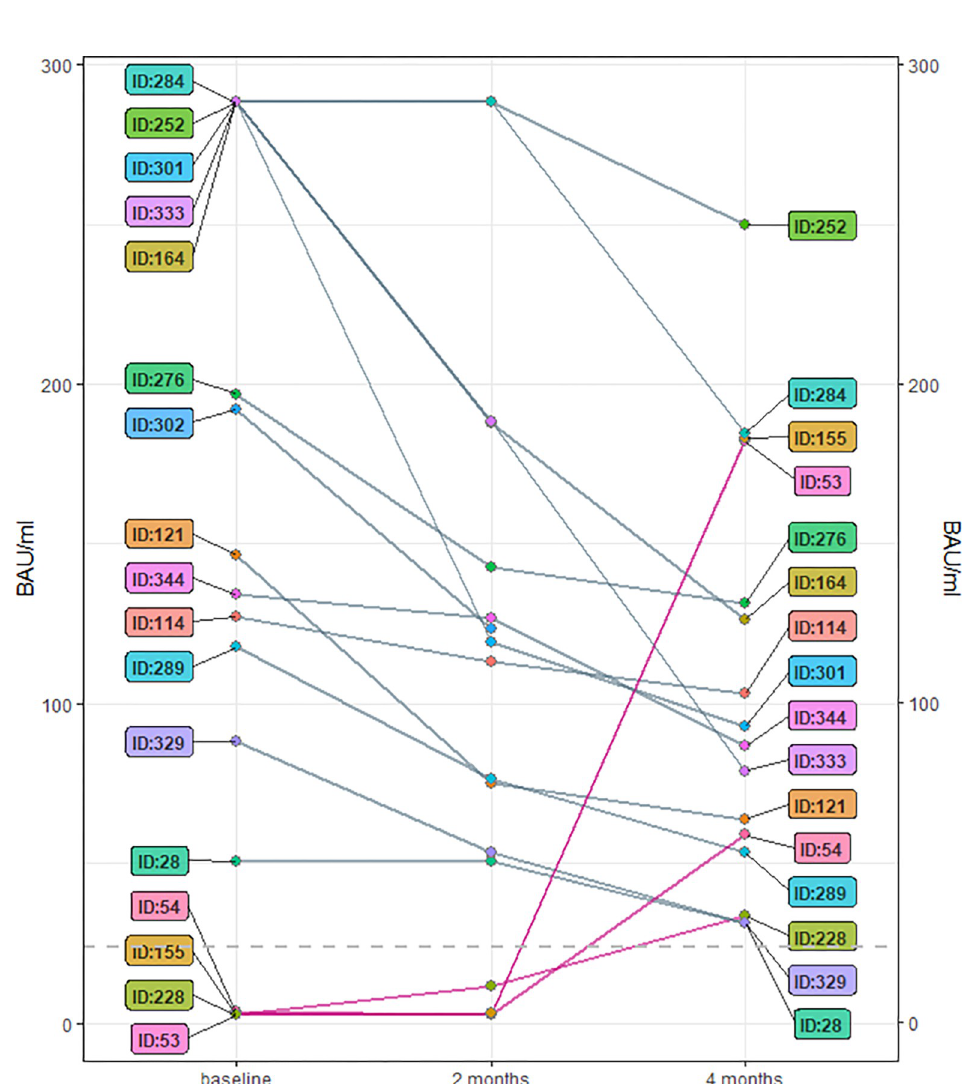
Fig 2. Before-and-after-plot: All children who tested positive for IgG-antibodies at least once during the study period. Every child is represented as an ID-number in the plot (n = 17 at baseline, and n = 16 at 4 months after baseline). The child with ID 302 was only tested at baseline and two months after baseline, so there was no third IgG- antibody value available. The grey dashed line at y = 24.0 BAU/ml represents the threshold for categorization into positive and negative results (a test result is IgG-positive at a level of � 24.0 BAU/ml). All seroconverted children are indicated by a red line.